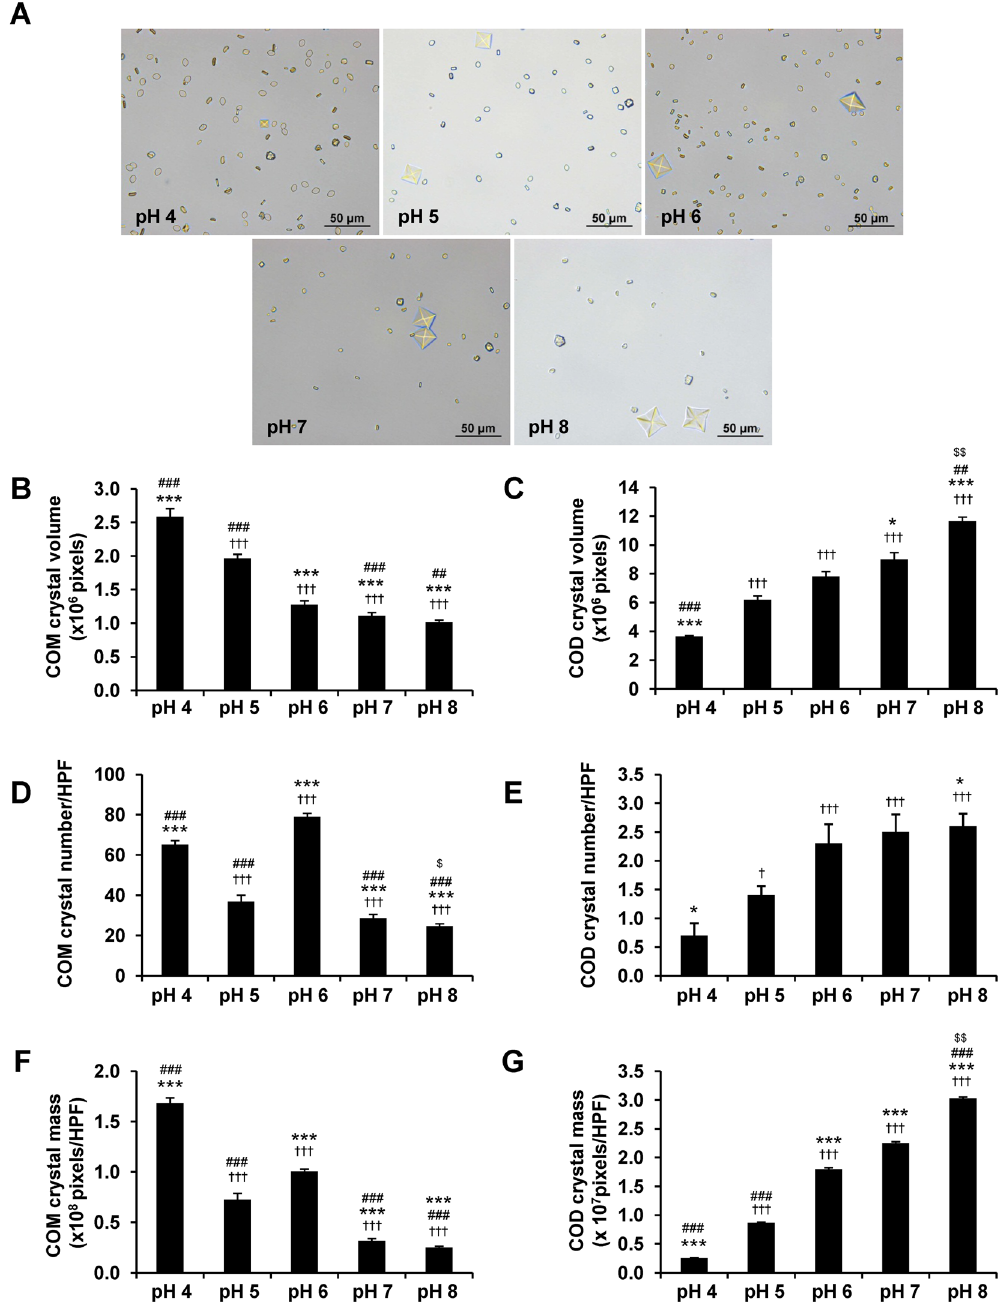
Figure 1. Effect of urine pH on CaOx crystallization. CaOx was crystallized in AU with varying pH (from 4.0 to 8.0). ( A ) Morphology of the resulting CaOx crystals (original magnification power was 400 × ). ( B ) COM crystal size (volume) measured from at least 100 crystals/each condition in each replicate. ( C ) COD crystal size measured from at least 20 crystals/each condition in each replicate. ( D , E ) Number of COM and COD crystals, respectively, counted from at least 10 HPF/each condition in each replicate. ( F , G ) COM and COD crystal masses (calculated from crystal size × crystal number). The data are reported as mean ± SEM of the data obtained from 3 independent experiments. † p < 0.05 vs. pH 4; ††† p < 0.001 vs. pH 4; * p < 0.05 vs. pH 5; *** p < 0.001 vs. pH 5; ## p < 0.01 vs. pH 6; ### p < 0.001 vs. pH 6; $ p < 0.05 vs. pH 7; $$ p < 0.01 vs. pH